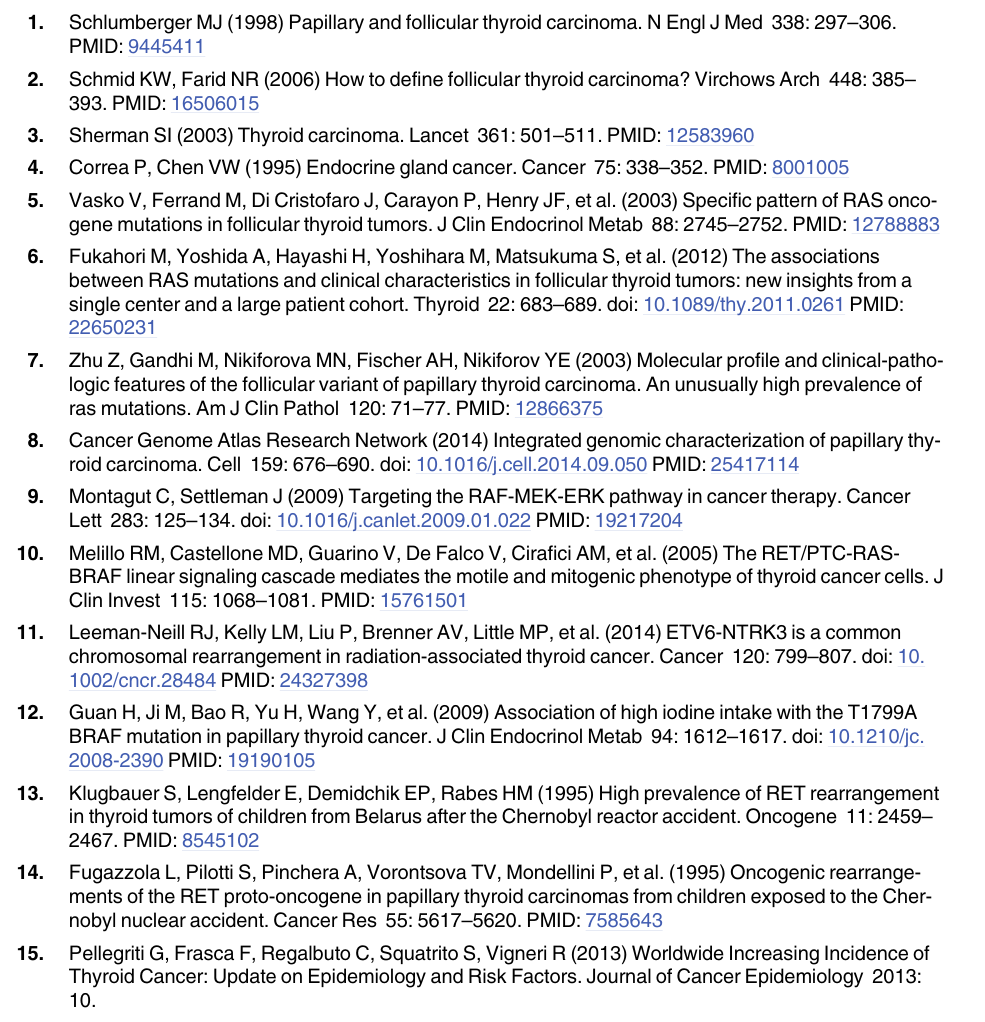
S6 Table. Clinical information of 180 patients. S7 Table. RNA sequencing throughput of all study subjects. S8 Table. The primer sequences used in this